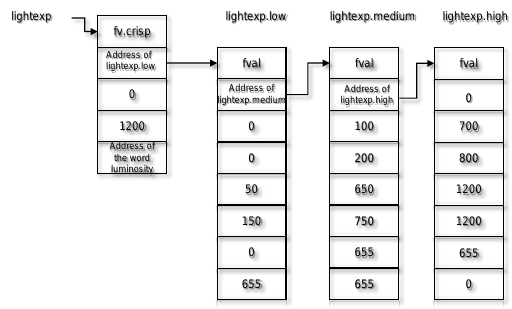
Figure 6. The execution of temp lightexp 2 classification thermal-zone creates the